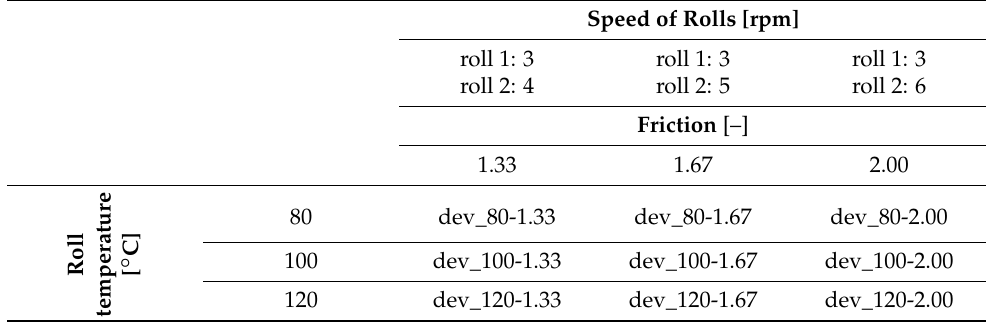
Table 2. Summary of devulcanisation parameters and devulcanisate nomenclature.